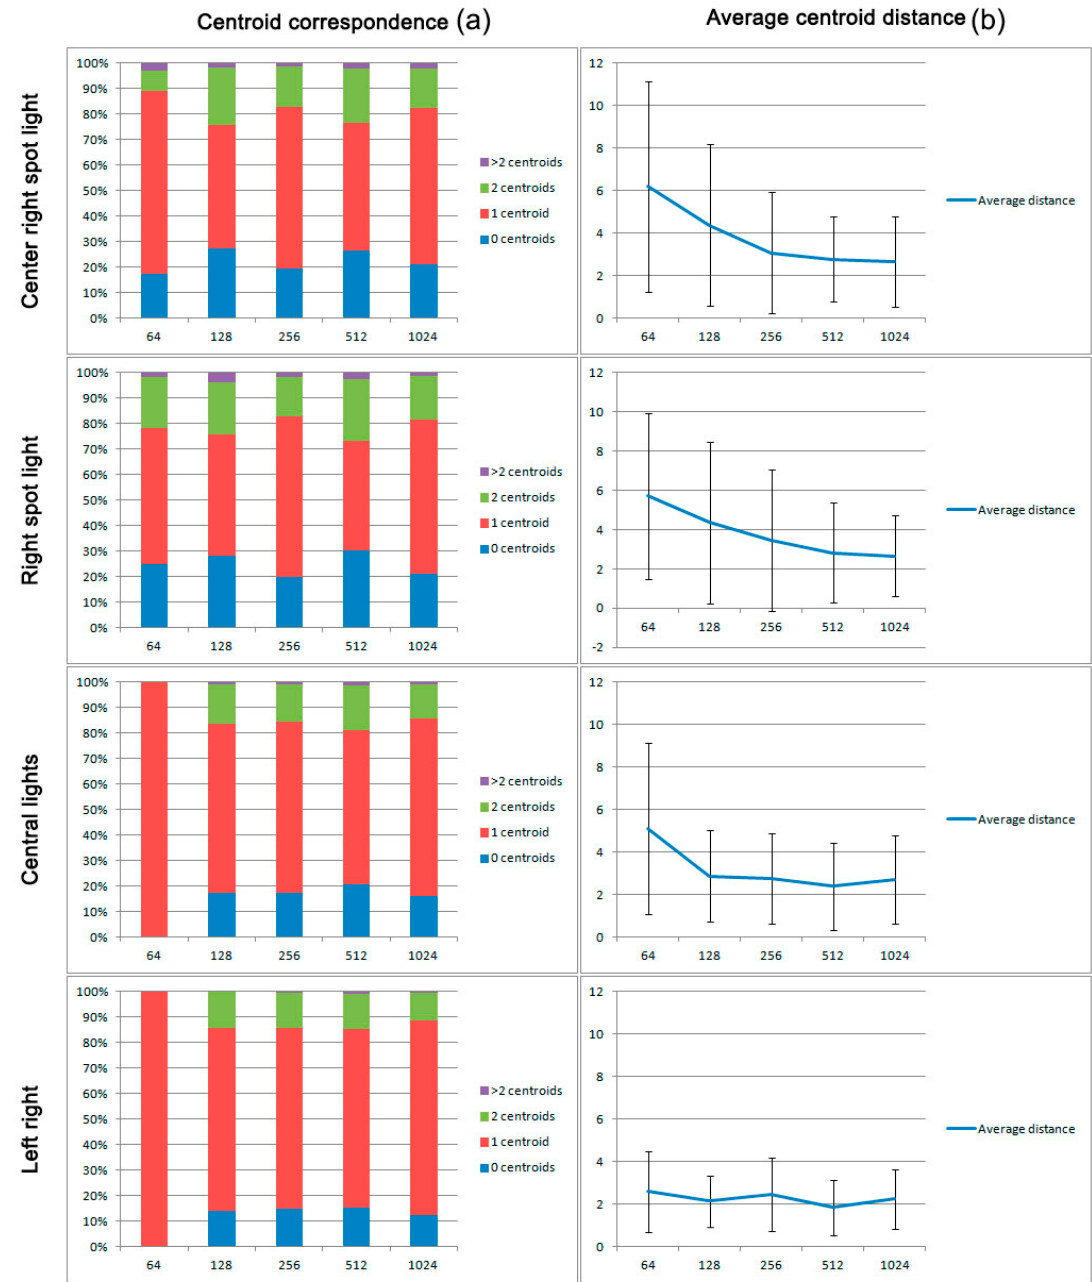
Figure 12. Number of correspondences (centroids which are closer) between each ideal centroid and the real ones ( a ). Standard deviation and average distance from the centroid to the geometrical center of the regions ( b ).